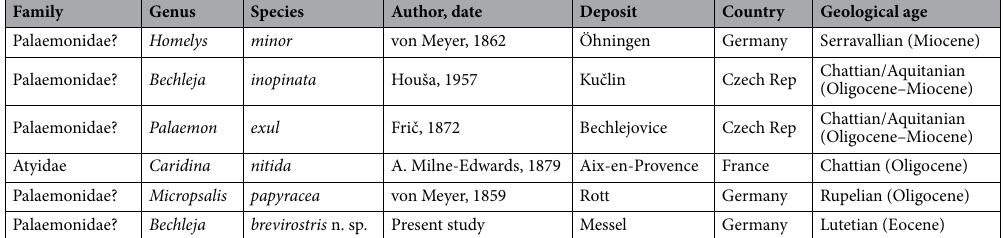
Table 1. Fossil record of freshwater shrimps in Cenozoic deposits of